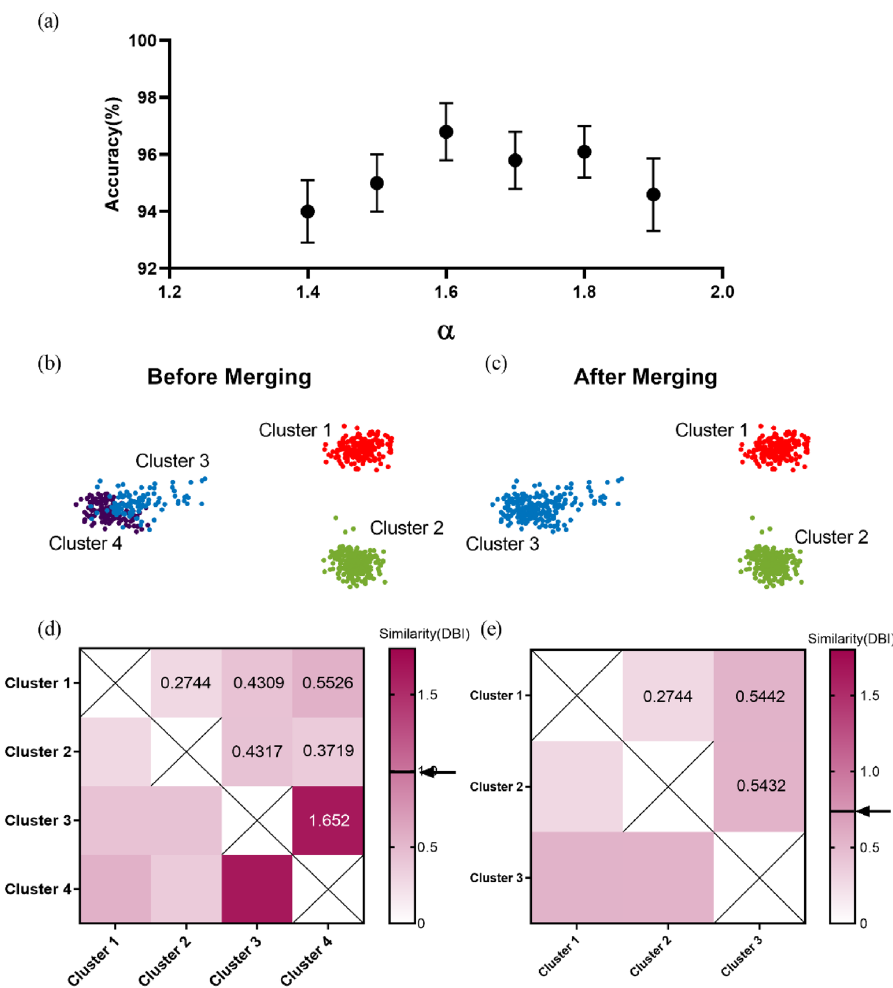
Figure 2. An illustration of determining the number of clusters. ( a ) Accuracy on all testing sets in dataset A versus threshold coefficient α . The error bars represent the standard error of the mean. ( b , c ) The results of classification before and after merging. Before merging, data points are clustered into four clusters (denoted by four colors: red, violet, green and blue), while after merging, we obtain three clusters (denoted by three colors: red, green and blue). ( d ) Heatmap of similarity between clusters before merging. The black solid line and the arrow mark the threshold (threshold = 0.99, see Formula (14)). It can be seen from the heatmap, the similarity between cluster 3 and cluster 4 is above the threshold, thus merging cluster 3 and cluster 4. ( e ) Heatmap of similarity between clusters after merging. At this time the number of clusters is 3, and the similarity between clusters is below the threshold (threshold = 0.73, see Formula (14)), the merging stage terminates. The number of clusters is finally determined to be